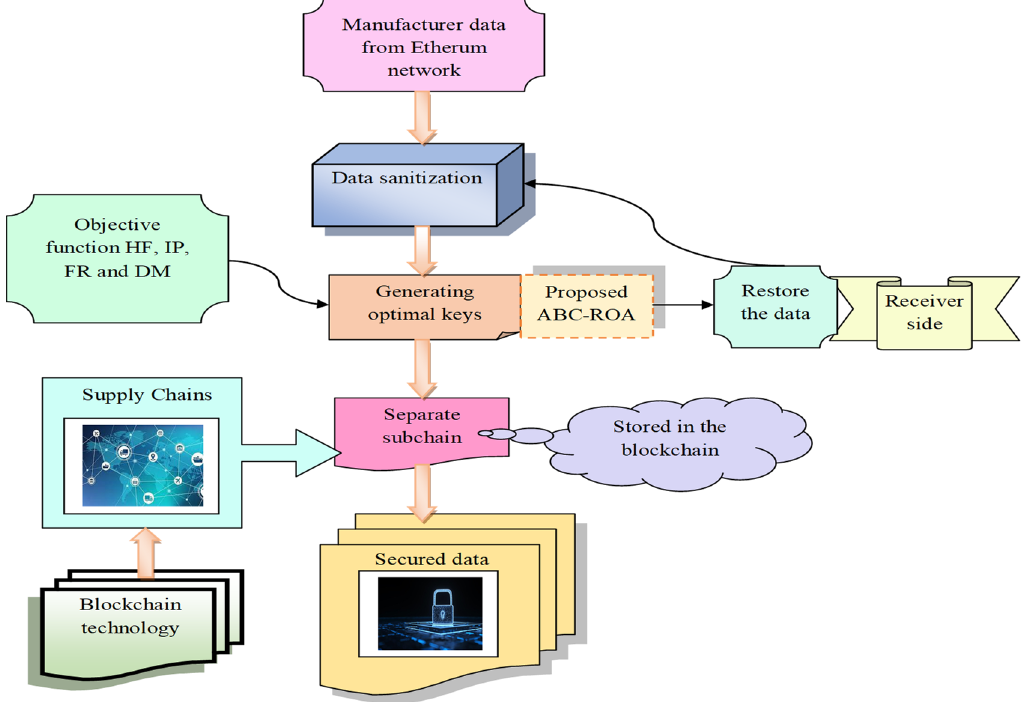
Figure 1. Architectural representation of the privacy preservation platform developed in the Ethereum blockchain.